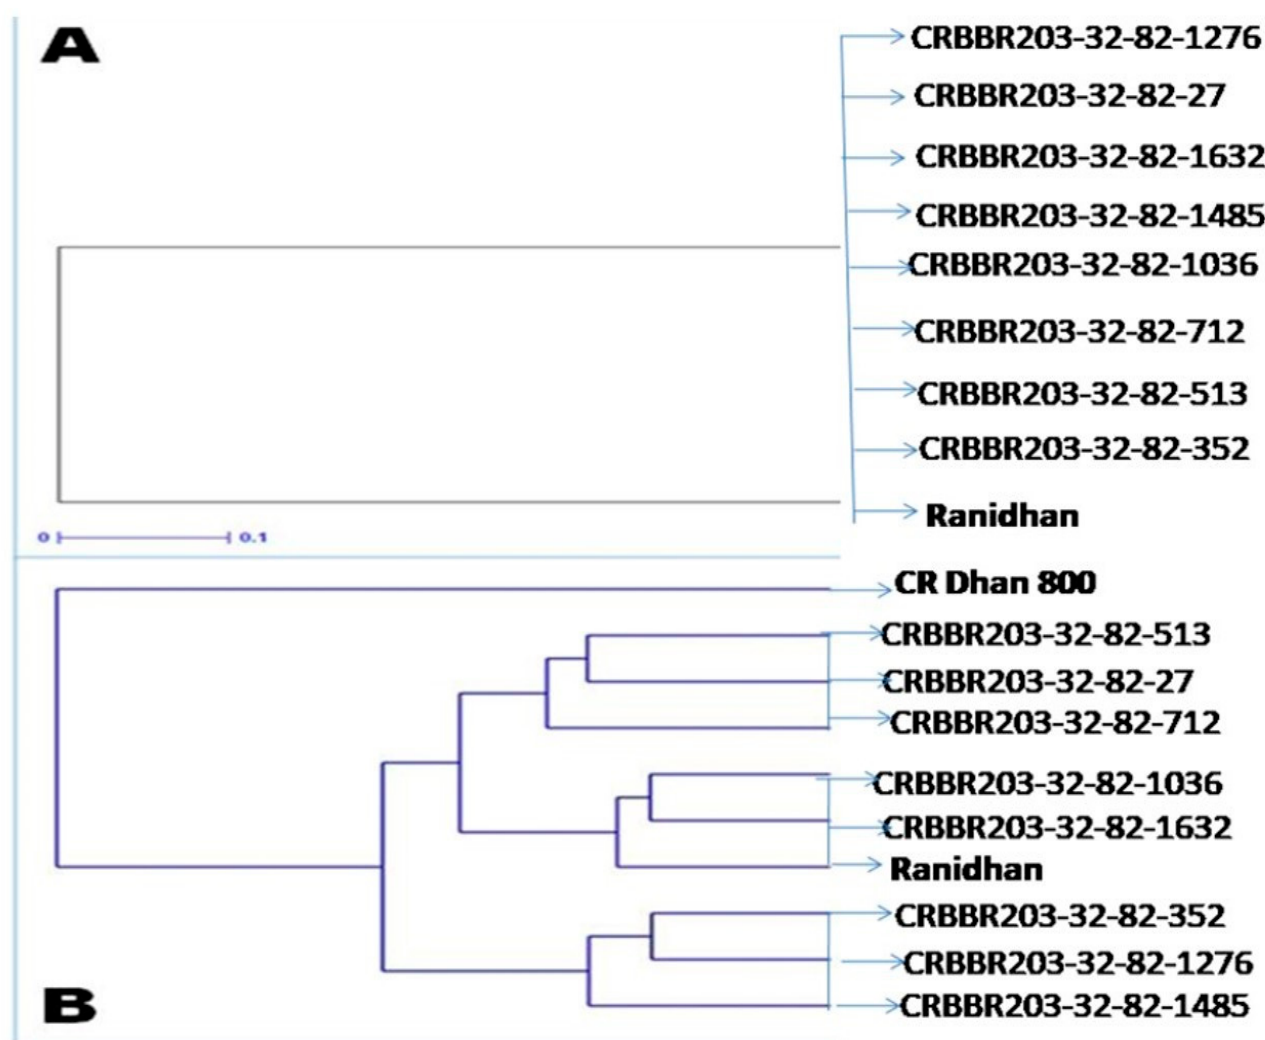
Figure 6. Dendrogram showing the relationship based on the phenotyping of 16 studied traits among ( A ) the 8 pyramided and recipient parent, Ranidhan and ( B ) the 8 pyramided and two parental lines.